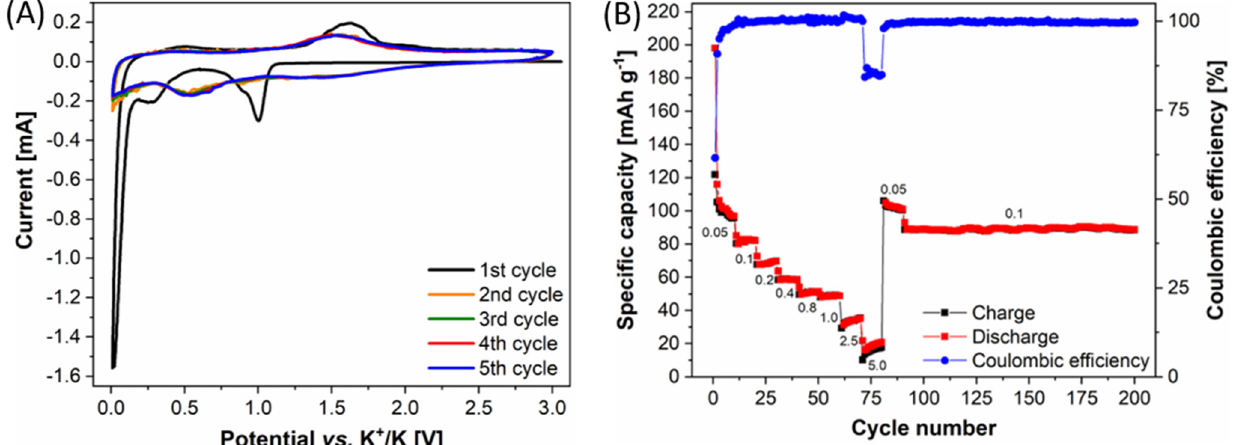
Figure 1. ( A ) Cyclic voltammogram (scan rate: 0.1 mV s –1 ) obtained with a T cell configuration, using potassium metal foil as counter and reference electrodes and MoS 2 as working electrode. ( B ) Galvanostatic charge/discharge cycling of a coin cell based on the MoS 2 anode.